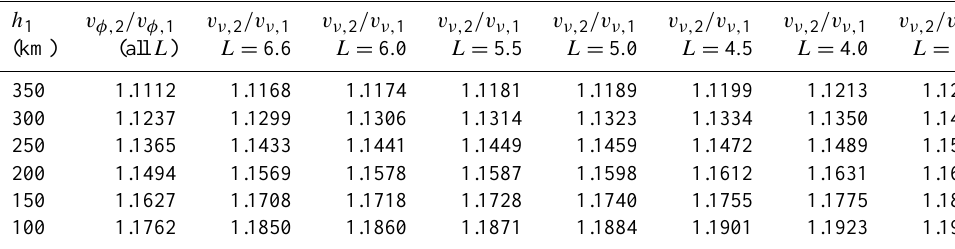
Table 1. Mapping of the convective drift from the ionosphere at height h 1 to DMSP altitude h 2 = 840km along dipole field lines of varying L . The ratio of the eastward ( φ ) components (column 2) does not change with L . The ratio of velocity components v ν in the magnetic meridian plane is given for various L .